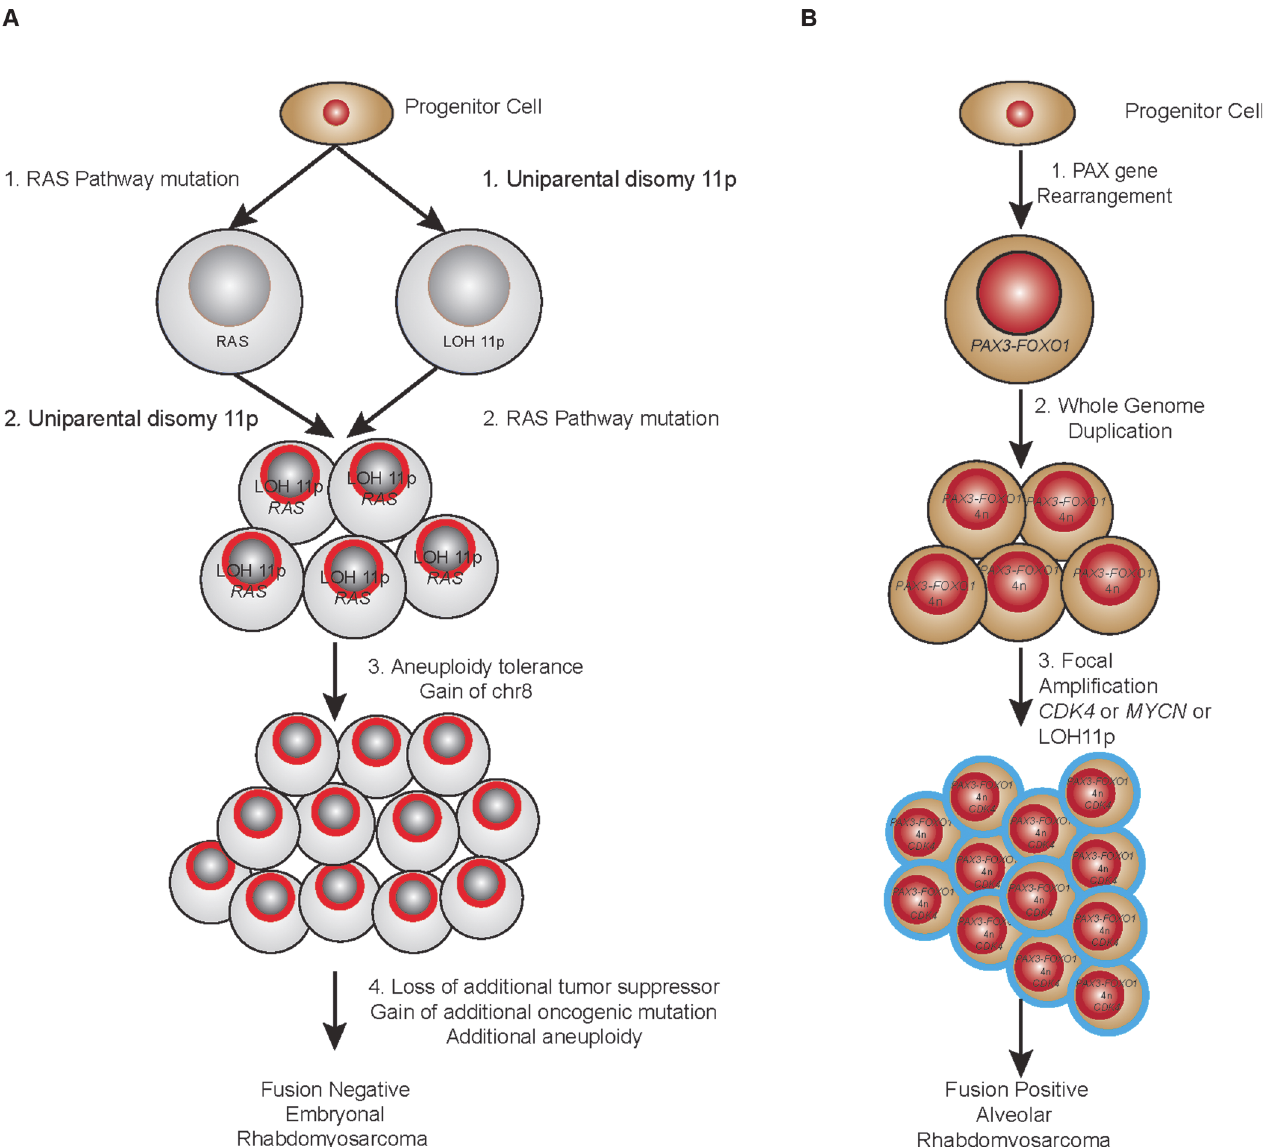
Fig 6. Proposed evolutionary model of rhabdomyosarcoma. (a) PFN samples. (b) PFP